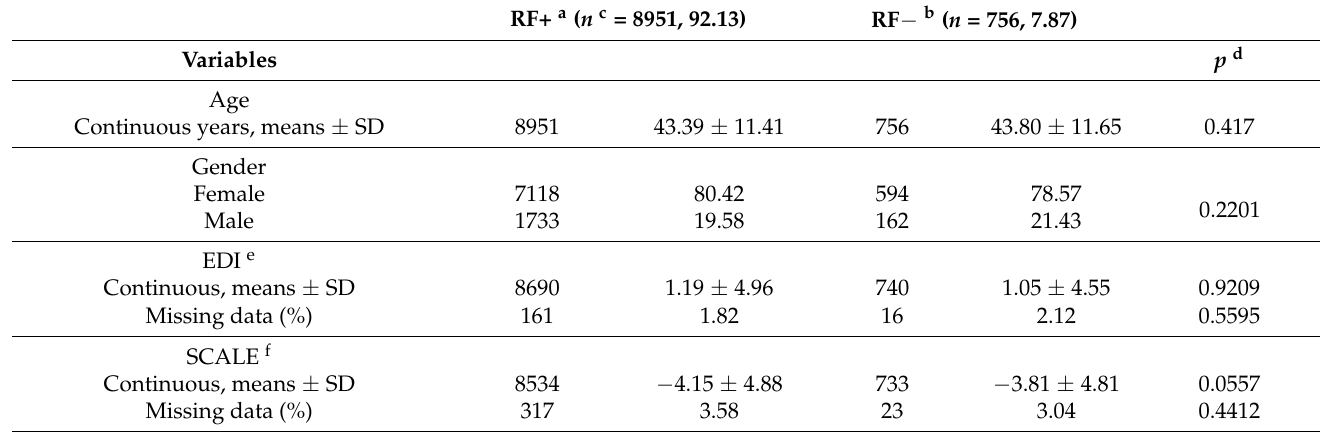
Table A4. Characteristics of patients included in the multilevel model for regularity of